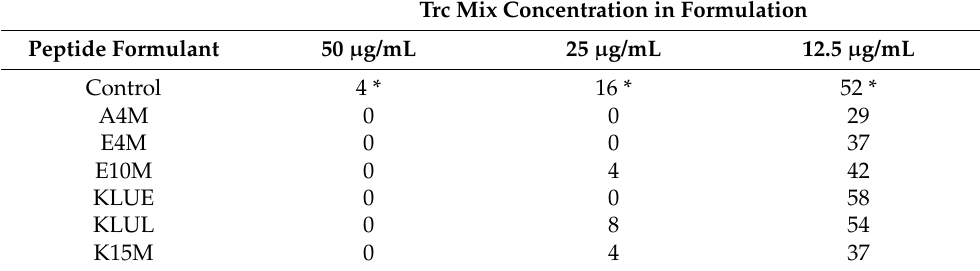
Table 2. Survival (%) of 24 cultures after exposure to the Trc mix and its formulations with a variety of saccharides at the three selected